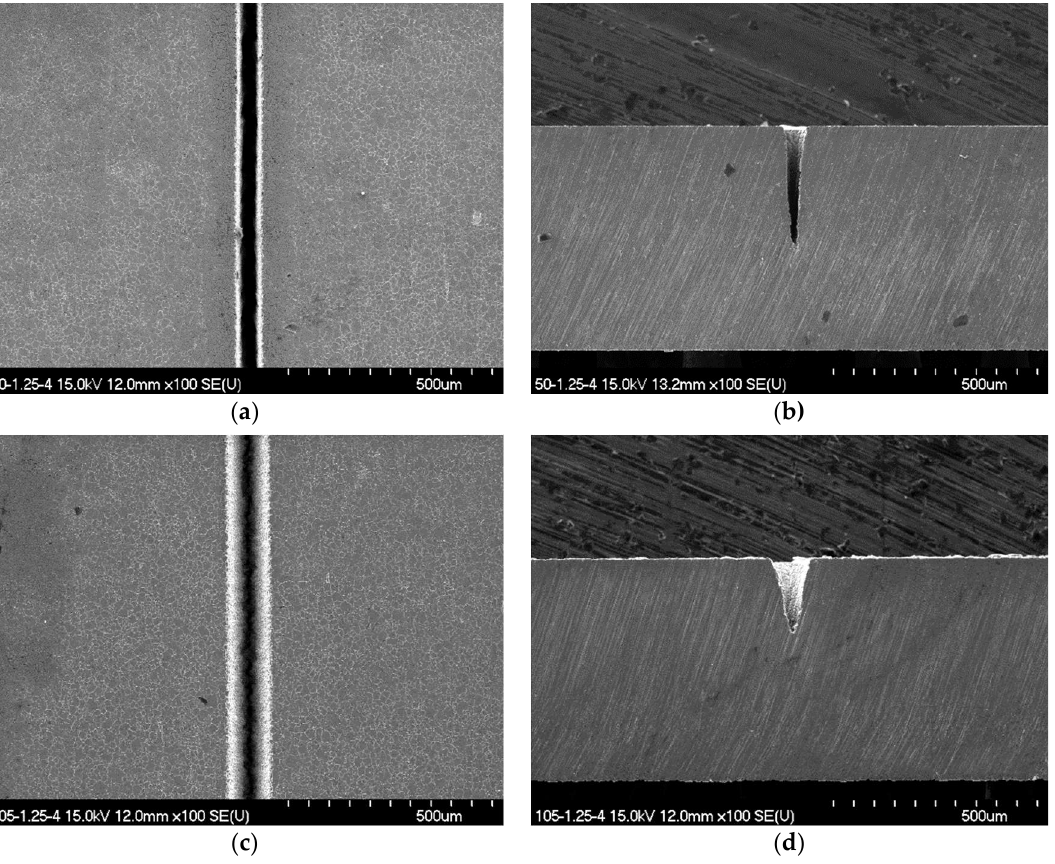
Figure 6. Scanning electron micrographs for the surface morphologies and cross-sectional profiles of stainless-steel 304 microgrooves fabricated in 10% H 3 PO 4 with two different core diameters using the optical fiber-based LIE: ( a , b ) 50 μm core fiber and ( c , d ) 105 μm core fiber. Other process variables were a laser power of 1.25 W and scan speed of 4 μm/s.